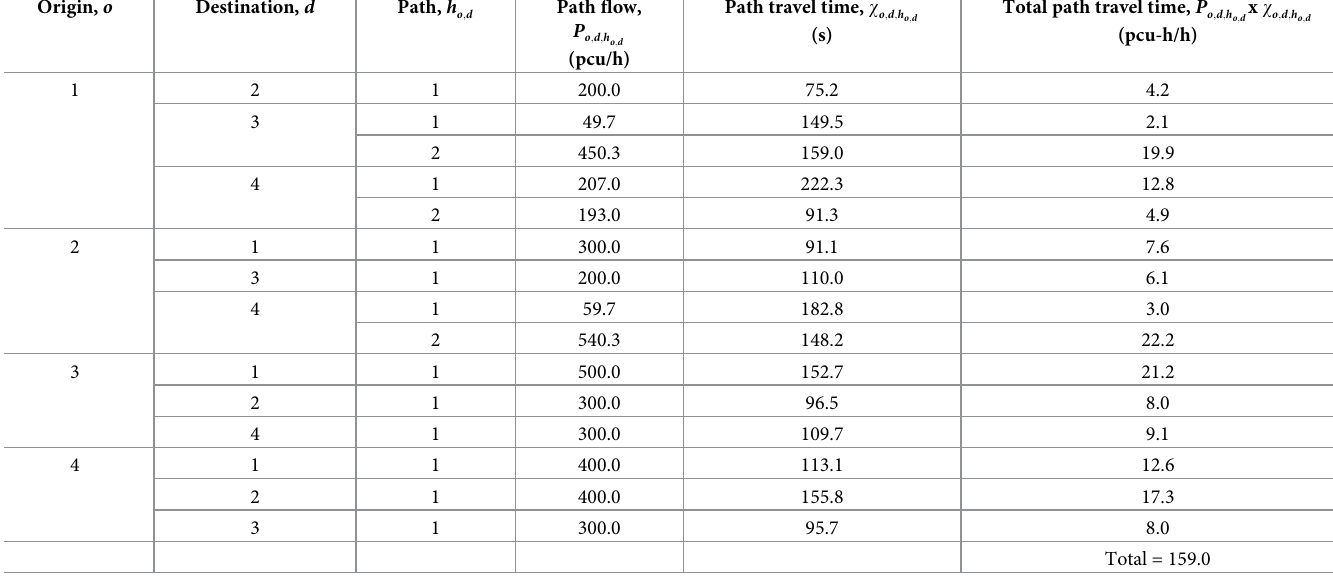
Table 7. Details of path flows and path travel times by maximizing the common flow multiplier m (= 1.075) with cycle length z ¼ 1 = 120 : 0 s. Origin, o